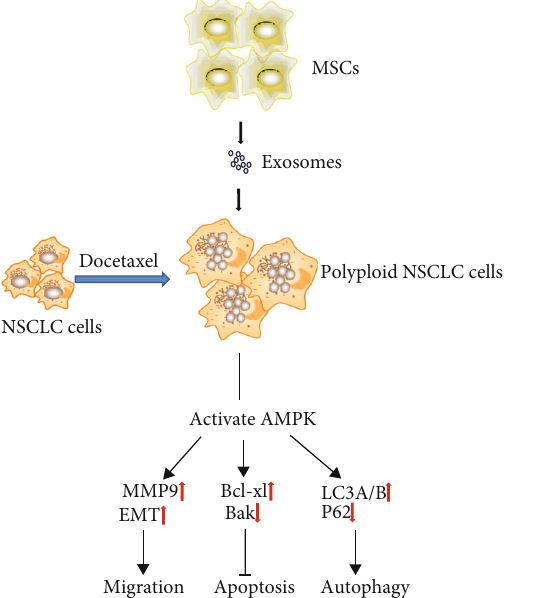
Figure 7: MSCs and MSC-exosomes may promote migration, antiapoptosis, and autophagy of polyploid NSCLC cells through the activated AMPK signaling